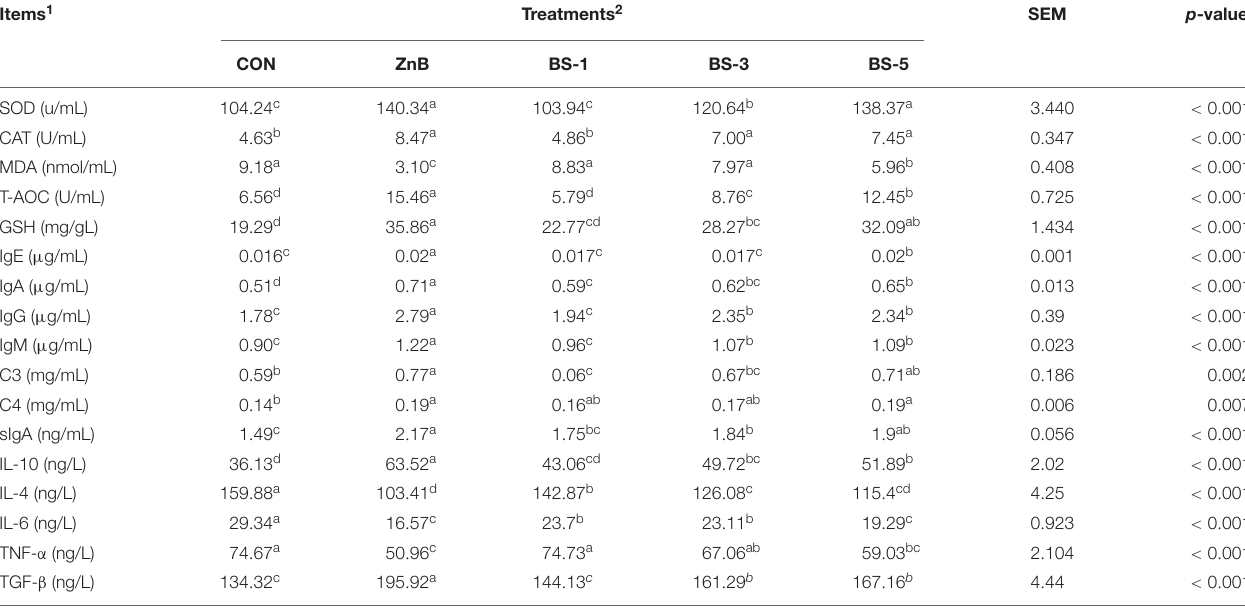
TABLE 3 | Effect of dietary supplementation of Bacillus subtilis ATCC19659 on the broiler’s serum antioxidant indexes, immunoglobulin, and cytokine profile. Items 1 Treatments 2 SEM